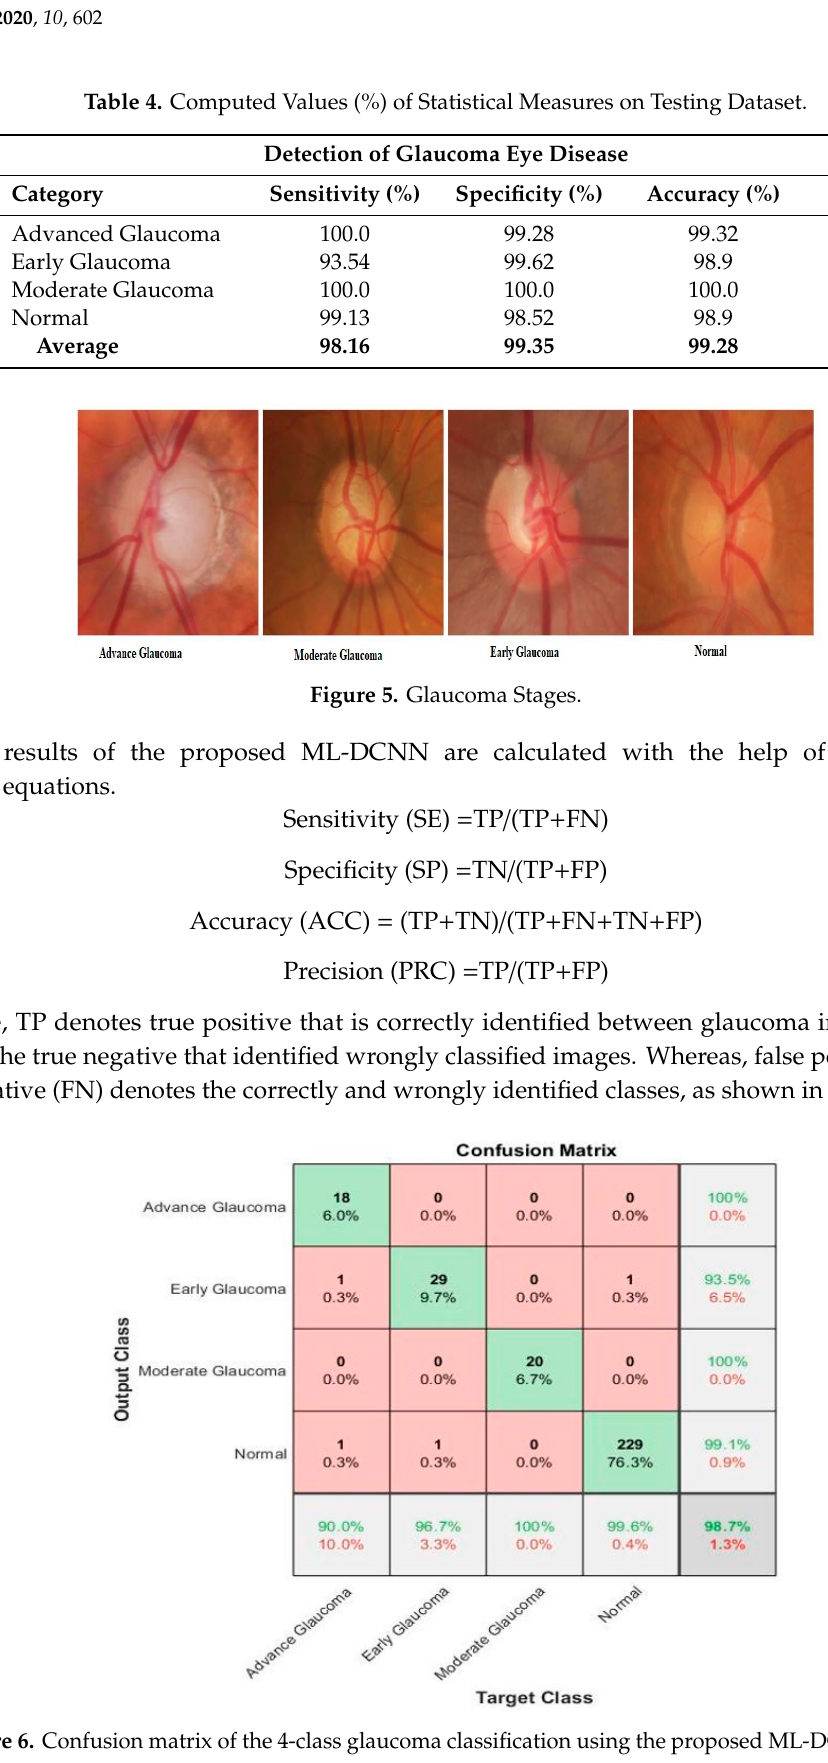
Table 3. Distribution of images in the different Groups (Classes) and Subsets.